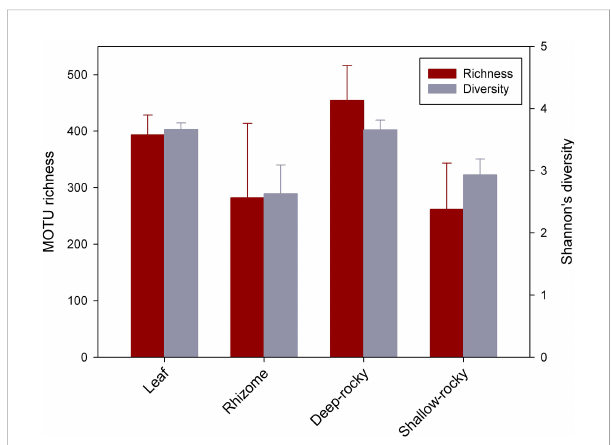
FIGURE 3 Mean MOTU richness (after rarefaction to a common number of reads), and mean Shannon diversity values of the samples corresponding to the main habitats sampled. Bars are standard errors.